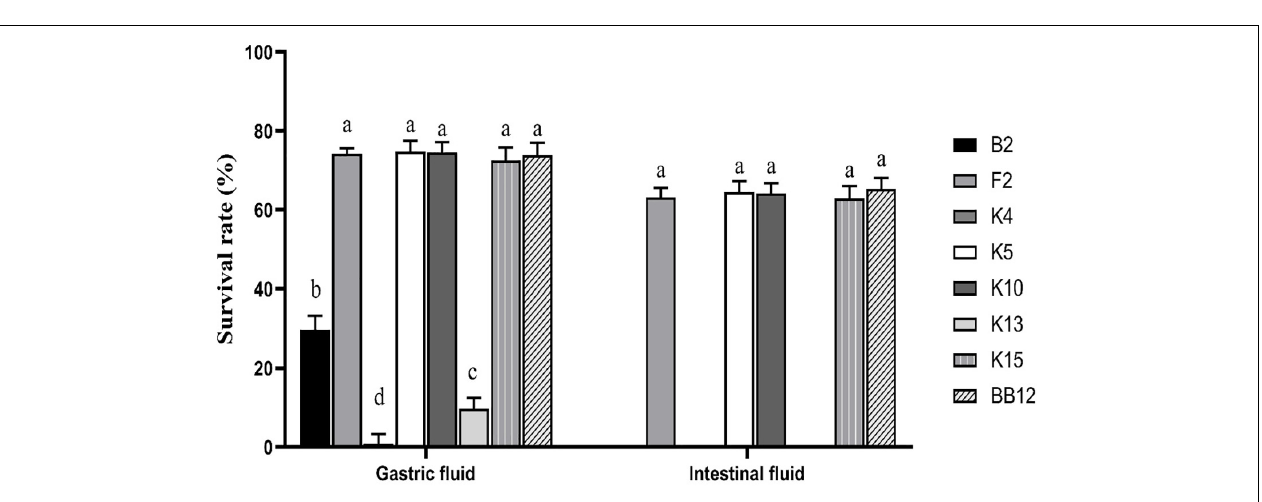
( p > 0.05) with the reference strain BB-12 (73.91%). B.